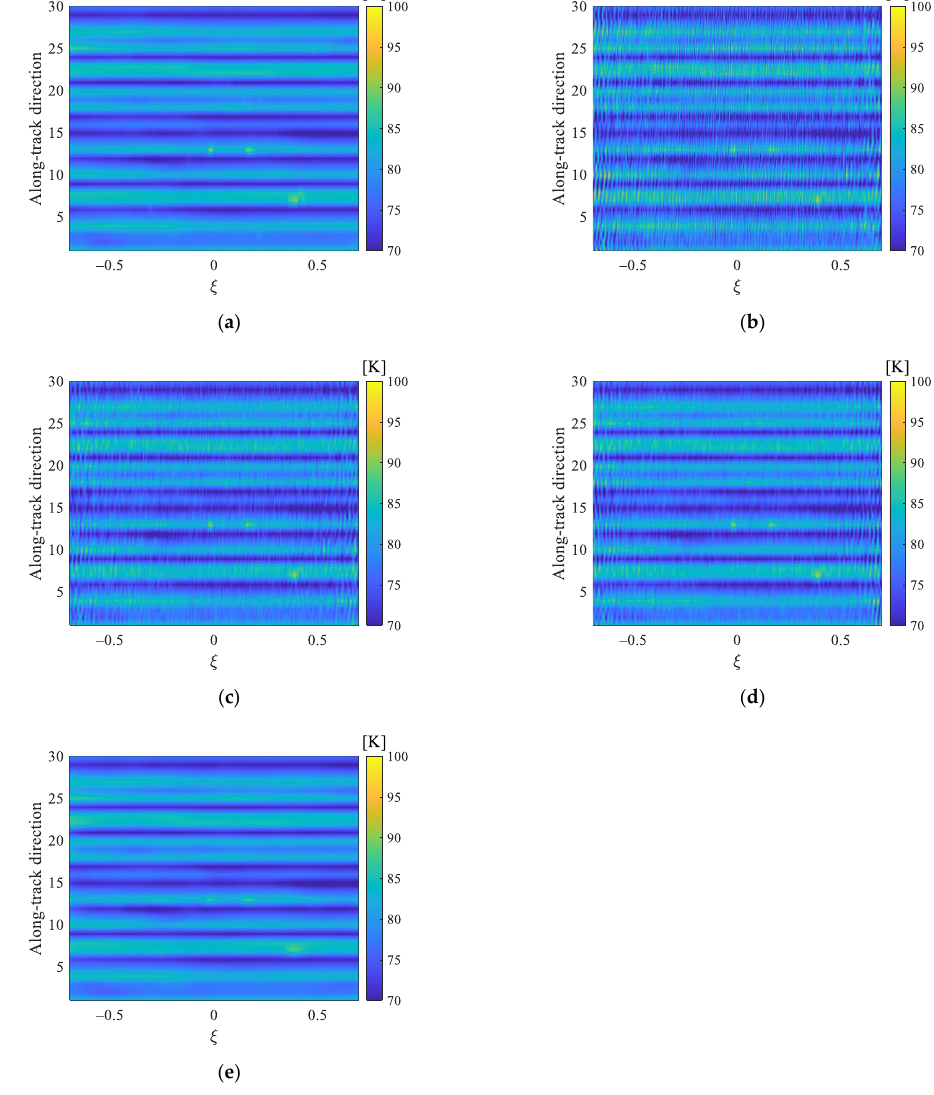
Figure 9. Reconstructed image by different regularization methods in the alias-free field of view: ( a ) the original image; ( b ) TV regularization; ( c ) Tikhonov regularization; ( d ) band-limited regularization; ( e ) multi-parameter regularization.